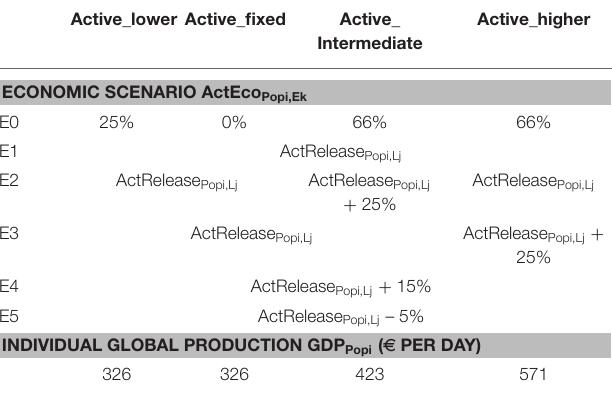
TABLE 2 | Economic scenarios and global production for the 4 active